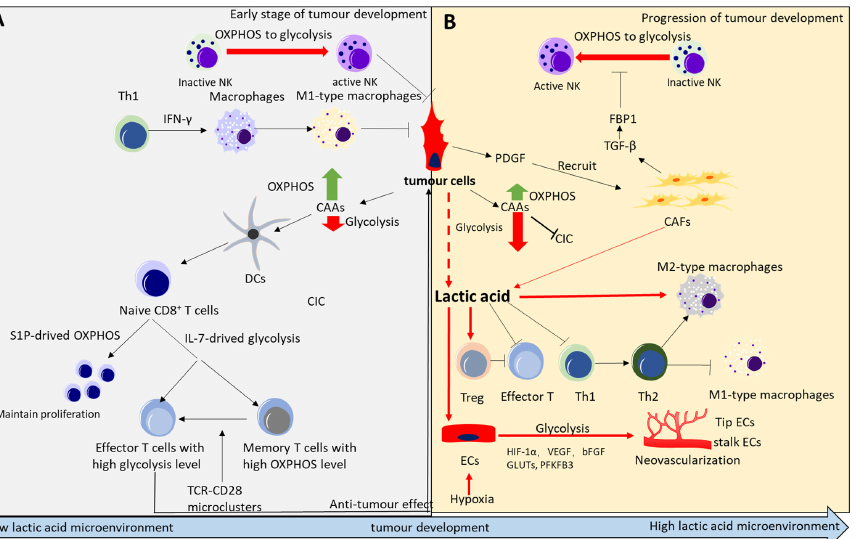
Figure 5. Effects of metabolic plasticity regulation on tumour microenvironment. The stages of tu- mour development are also per stage of adapting and transforming for the microenvironment. ( A )